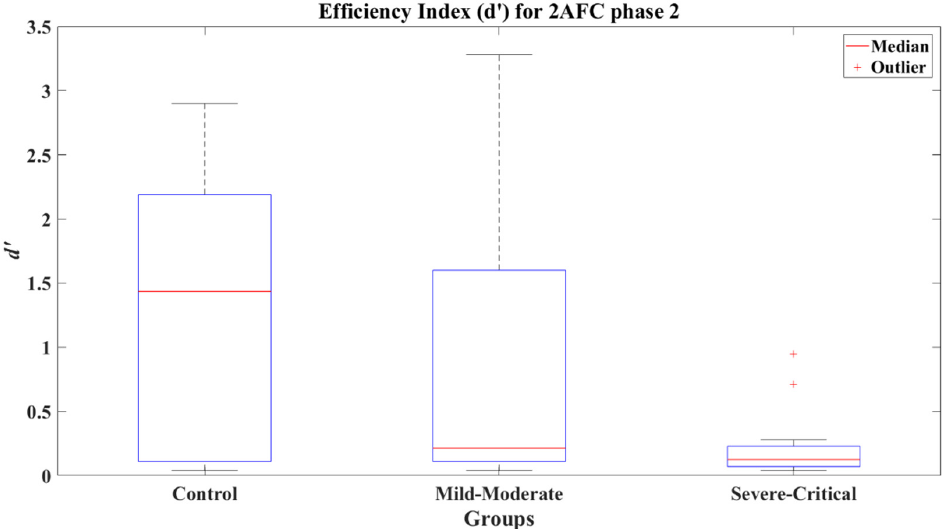
Figure 9. Efficiency index d’ for 2AFC-P2 by group.